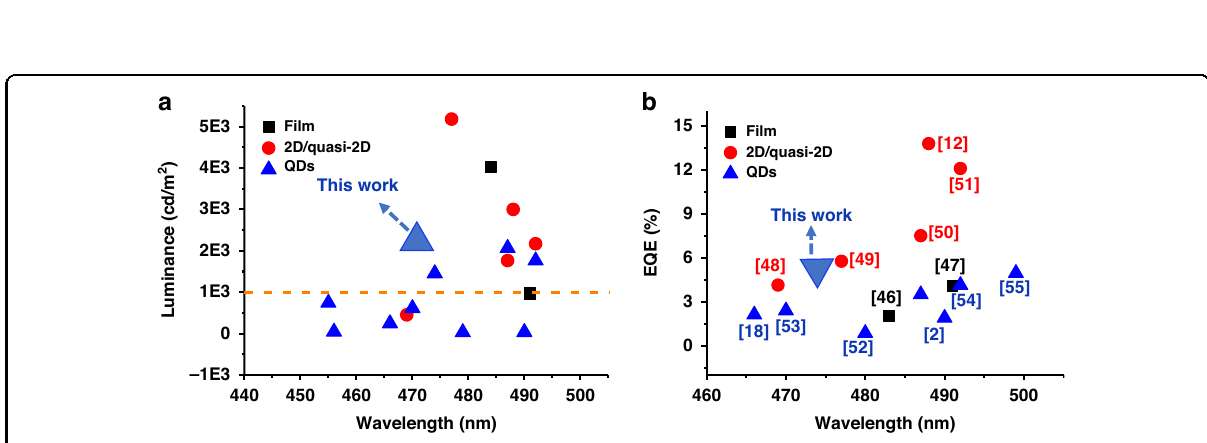
Fig. 7 The development state of blue perovskite LEDs. The blue perovskite LEDs performance statistical graph a Luminance-Wavelength data and b EQE-Wavelength data. Ref. 46,47 is perovskite fi lm LEDs, Ref. 12,48 – 51 is 2D/quasi-2D perovskite LEDs, Ref. 2,18,52 – 55 is perovskite QD